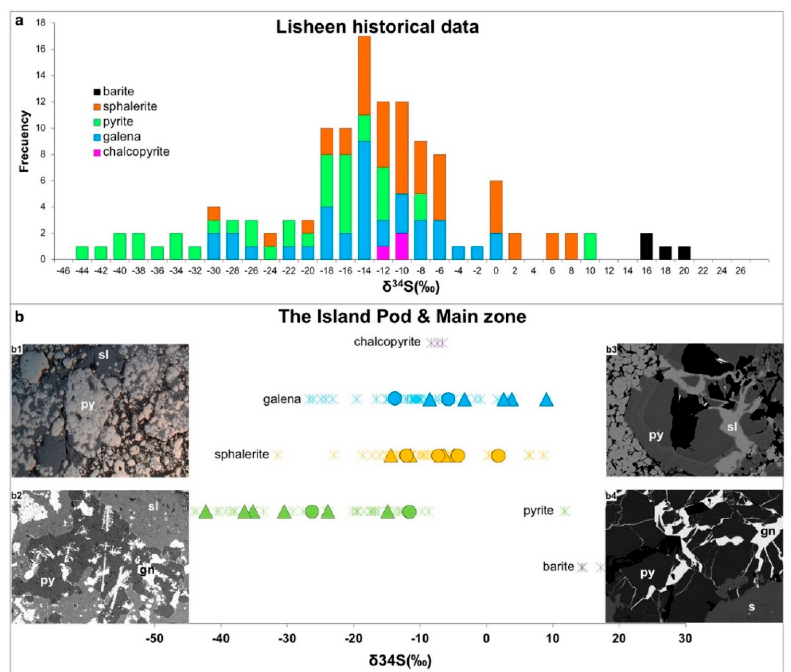
Figure 8. S isotope analyses from the Lisheen system. ( a ) Histogram showing published S isotope data [12]; ( b ) plot distinguishing new S isotope data (Table A1) from the Island Pod (IP) (triangles) ( b1 , b3 , and b4 ); Main zone oolite-hosted (MZ) (circles) ( b2 ) and published data from Main zone (crosses). New S isotope analyses are also compared with mineralogy, textures, and paragenesis. ( b1 ) Early pyrite (py) partially replaced by the later sphalerite (sl); ( b2 ) early dendritic galena (gn) associated with pyrite; ( b3 ) early zoned, euhedral pyrite, with fracture infilling by the later sphalerite; and ( b4 ) late fracture-filling galena in massive